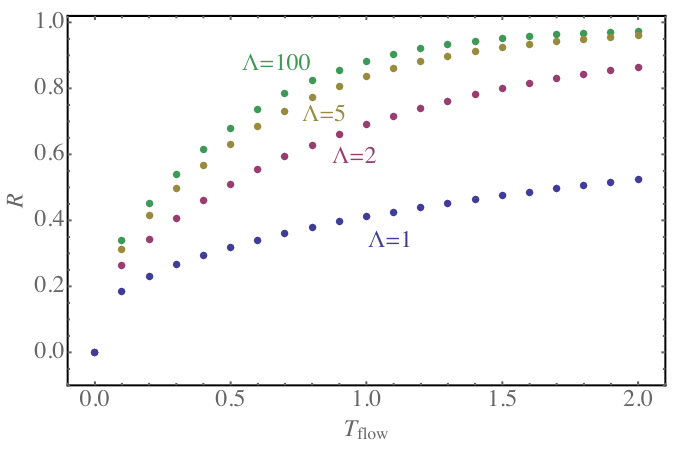
Figure 3 . T (cid:13)ow -dependence of the reweighting factor for the Airy integral at various